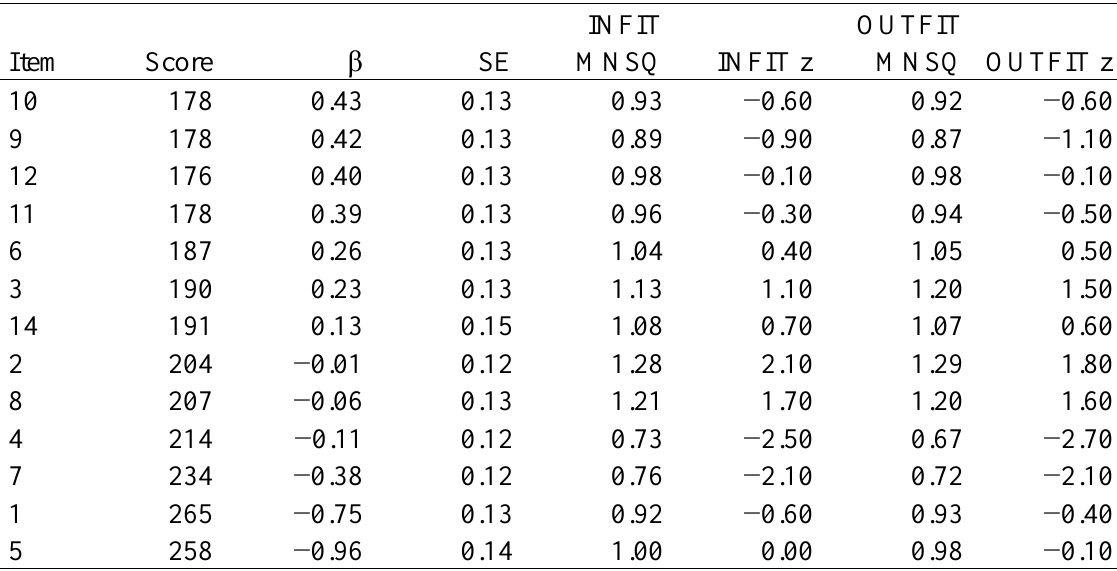
Table 2. Item characteristics of revised model (FMI-13) sorted by item